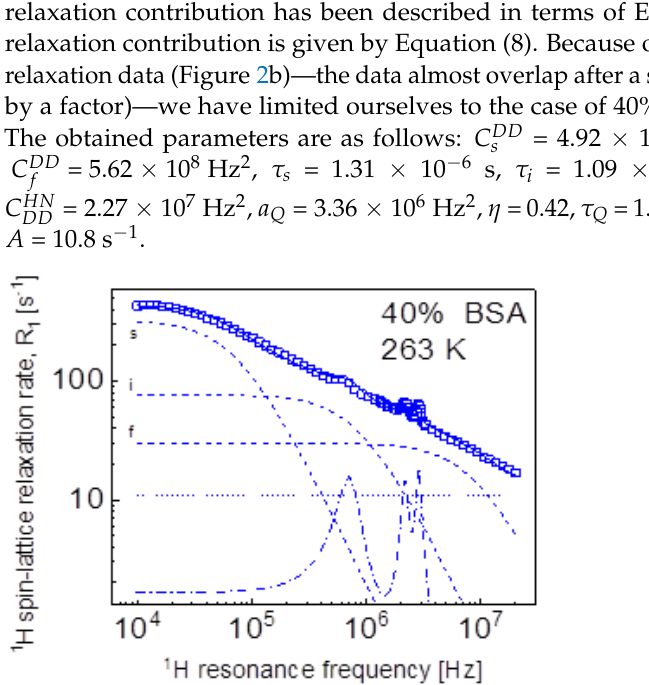
Figure 9. 1 H spin-lattice relaxation data for BSA–water mixture (40%wt of BSA) at 263 K reproduced as a sum of Equation (3) ( 1 H- 1 H relaxation contribution) and Equation (10) ( 1 H- 14 N relaxation contribution); solid line — overall fit decomposed into the 1 H- 1 H relaxation contributions associated with slow, intermediate, and fast dynamics (dashed lines), dashed-dotted line — 1 H- 14 N relaxation contribution, dotted line — a frequency independent term.